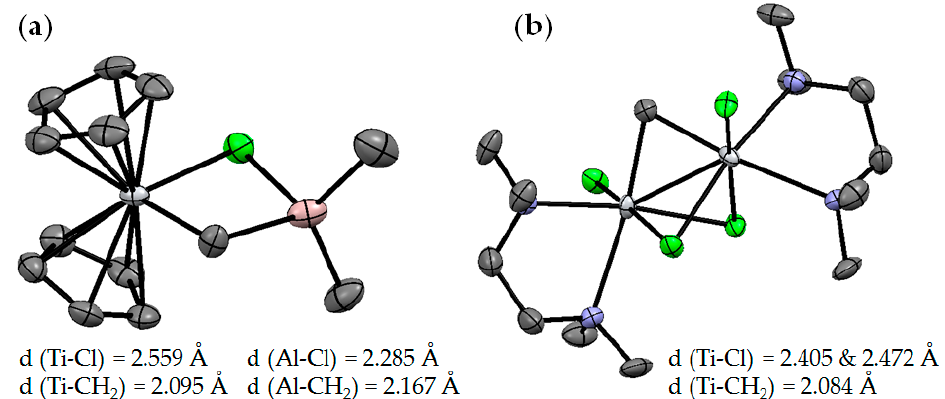
Figure 2. Molecular structures of ( a ) Ti01 [50] and ( b ) Ti02 [51]. The hydrogen atoms are omitted for clarity.